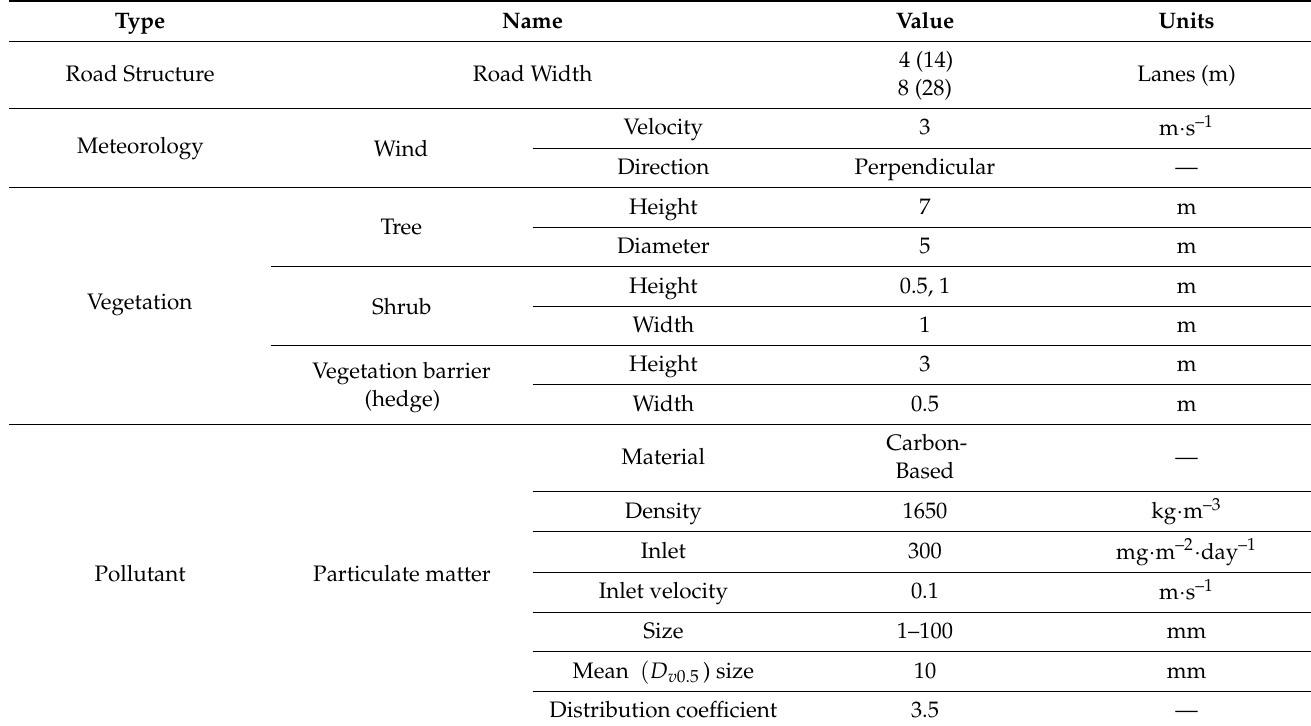
Table 2. Summary of key simulation